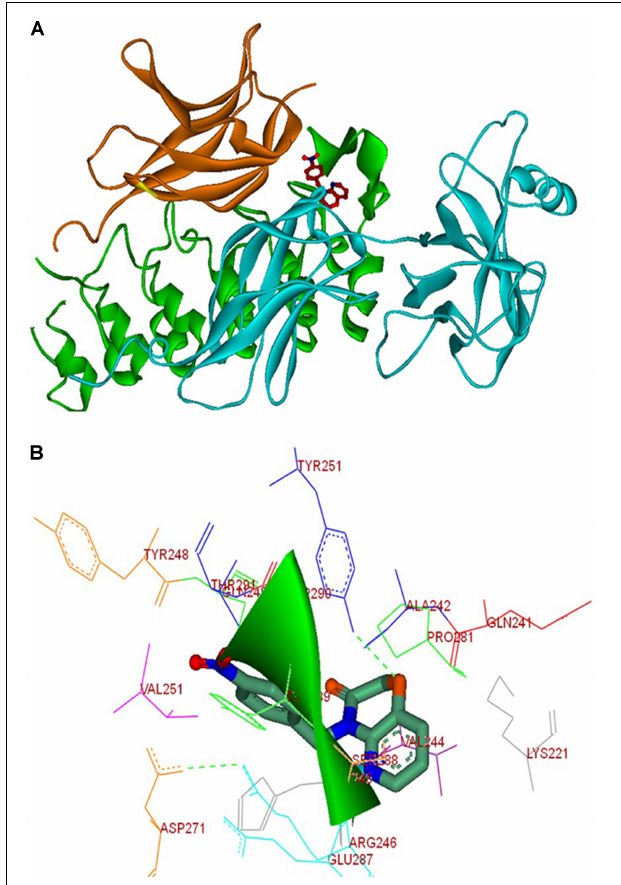
FIGURE 5 | Molecular interactions between NPO and the I κ B α /NF- κ B complex. (A) Molecular docking solution for NPO (in stick representation, and atomic coloring with orange) targeting I κ B α /NF- κ B complex. The p50 sub-unit is show in orange, p65 in cyan, and I κ B α in green; (B) the interaction map of the complex formed between NPO and I κ B α /NF- κ B complex is